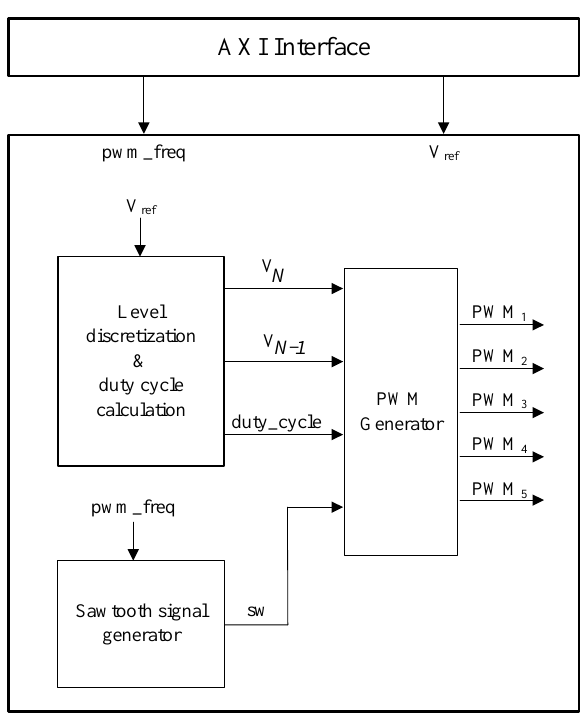
Figure 20. Block diagram per arm of the implemented NLM.